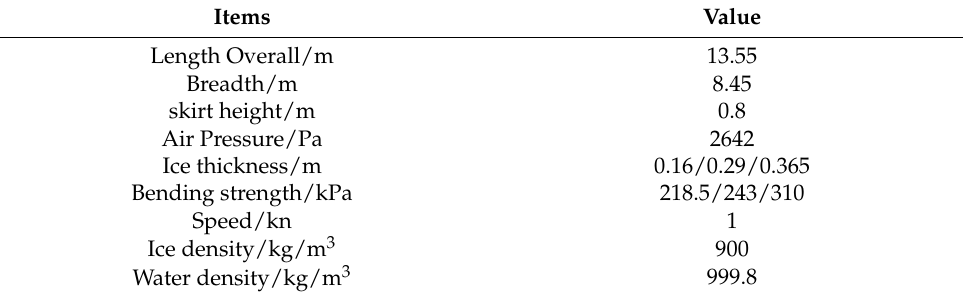
Table 3. Ship and ice characteristics.